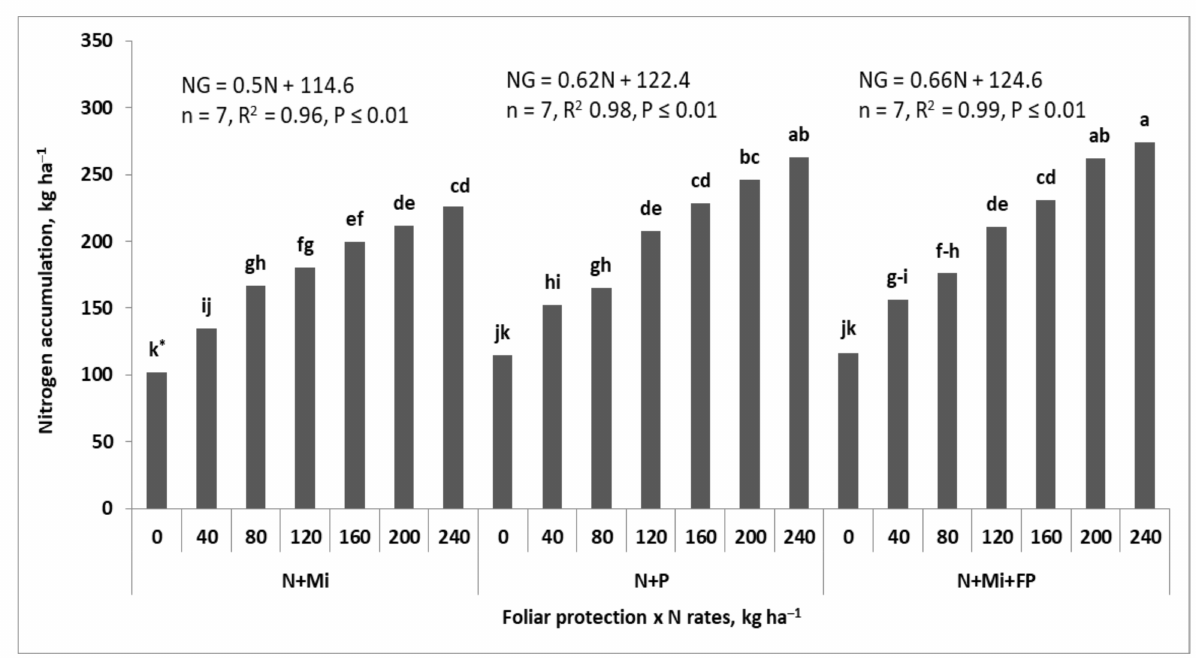
Figure 3. Response of grain nitrogen by winter wheat to interaction of foliar protection systems and N rates. * Similar letters means a lack of significant differences using Tukeys’ test. Legend: N + Mi—N and micronutrients; N + P—N + fungicides; N + Mi + P—N plus micronutrients and